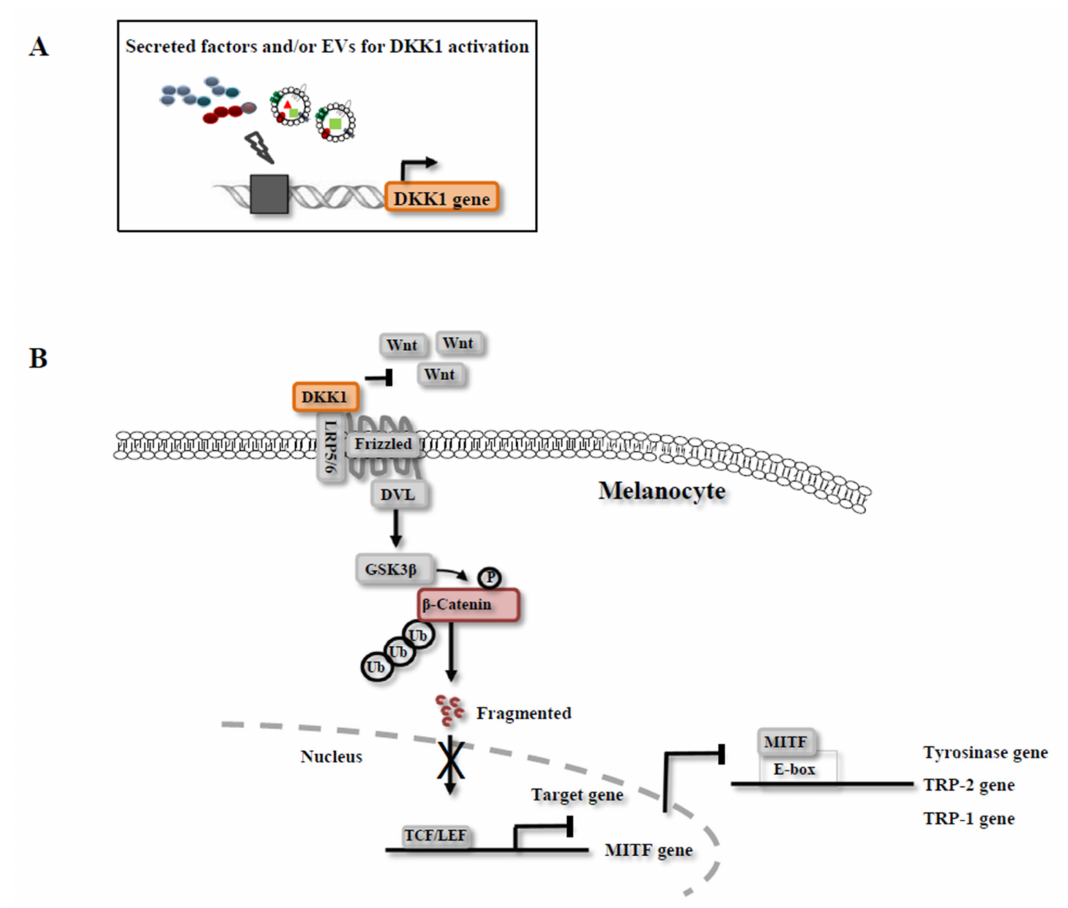
Figure 3. Signaling pathways for melanin inhibition by NSC-CM. The expression of Dickkopf-1 (DKK1) gene may directly or indirectly be induced by NSC-CM in melanocytes ( A ), which decreased the melanin synthesis via the inhibition of Wnt/ β -catenin signaling pathway and subsequent downregulation of the expression of MITF and melanogenic enzymes ( B ). The thunder symbol indicates DKK1 gene may directly or indirectly be induced by NSC-CM. TCF/LEF, T-cell factor/lymphoid enhancer factor; MITF, Microphthalmia-associated transcription factor; DVL, Dishevelled; GSK3 β , Glycogen synthase kinase 3 β ; LRP5/6, Lipoprotein receptor-relased protein 5/6; Ub, Ubiquitination. 4. Exosomes in